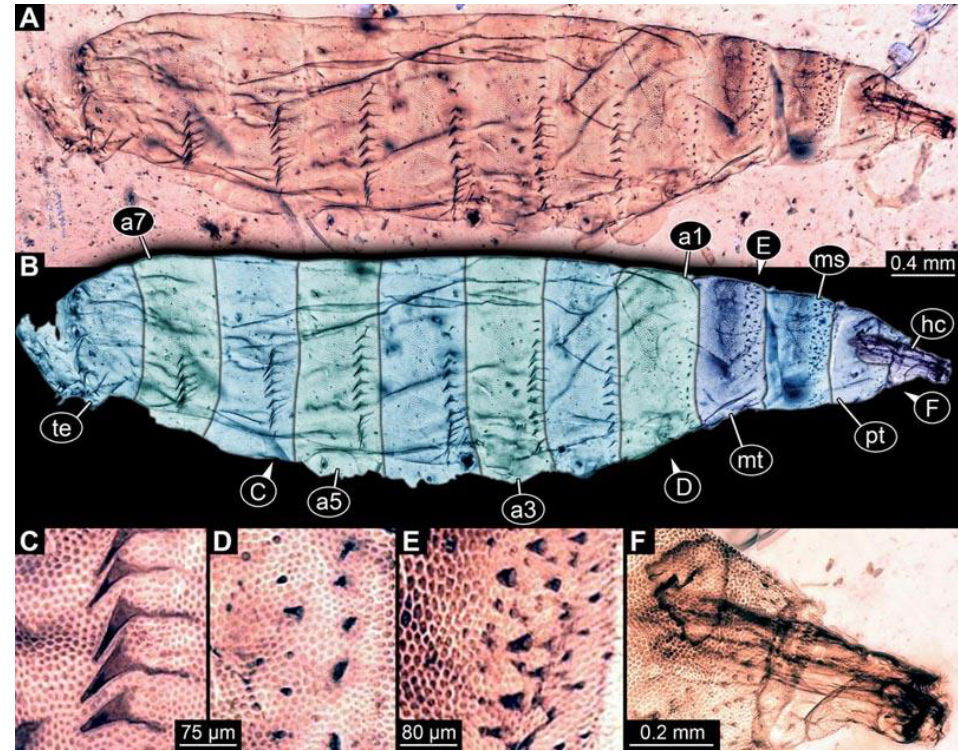
Figure 6. Fossil larva of morphotype 1, specimen PED 1276. ( A ). Lateral view. ( B ). Colour-marked. ( C – E ). Close-up of spine-like setae. ( F ). Close-up of head capsule. Abbreviations: a1 – a7 =